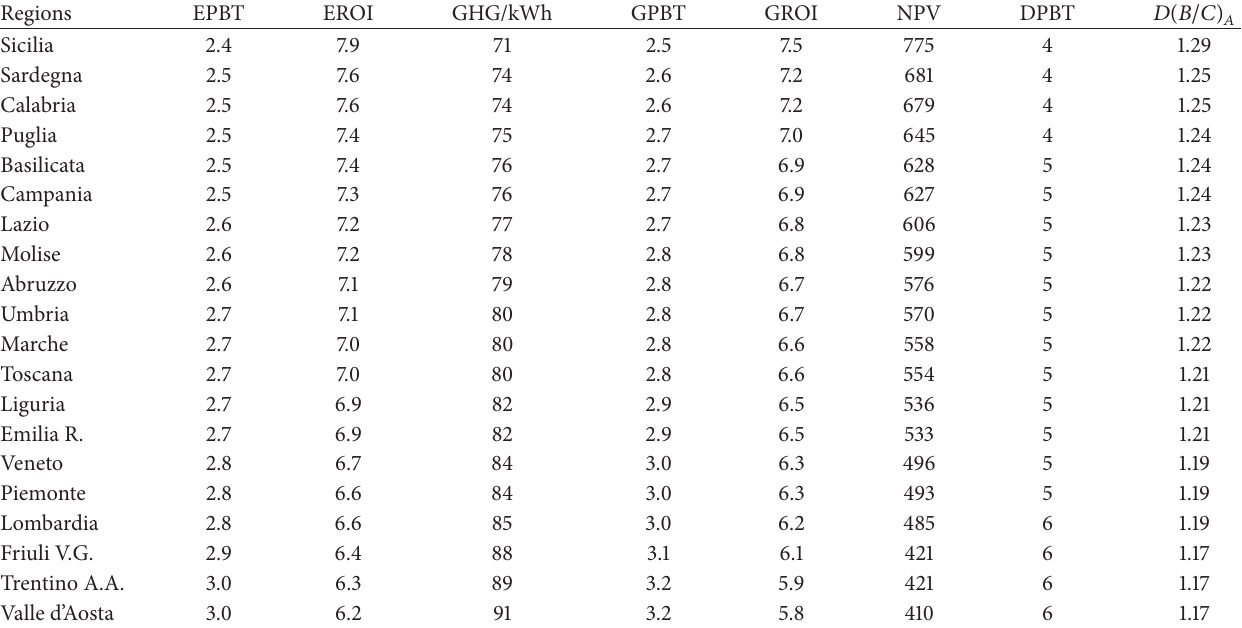
Table 1: Economic, energetic, and environmental indicators.